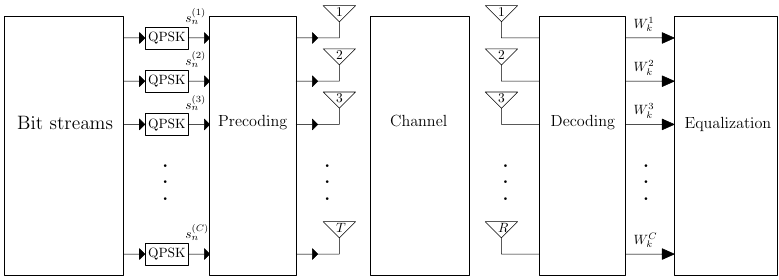
Figure 2. Proposed MIMO SVD-based system, employing T transmitting antennas and R receiving